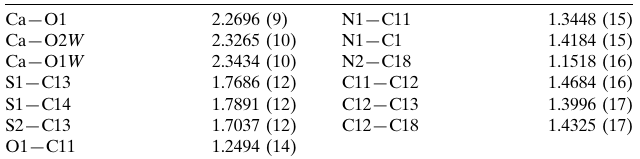
Selected bond lengths (A˚ ).